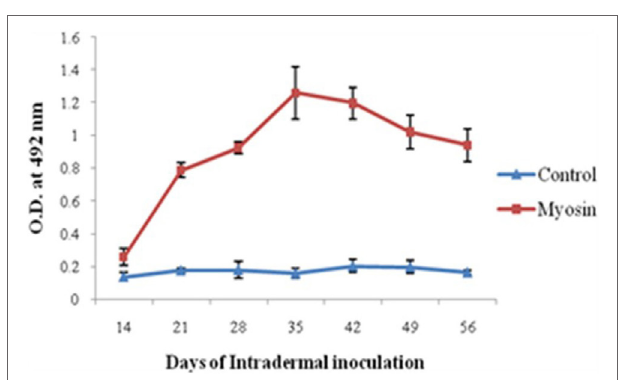
FigUre 4 | Comparison in levels of autoantibodies against myosin in sera of Mycobacterium leprae soluble antigen-hyperimmunized female BALB/c mice, pre-immunized mice, and control mice. Each dot represents individual OD obtained from mouse plasma. Solid horizontal line with error bars represent mean OD with SEM (*** p < 0.0001).